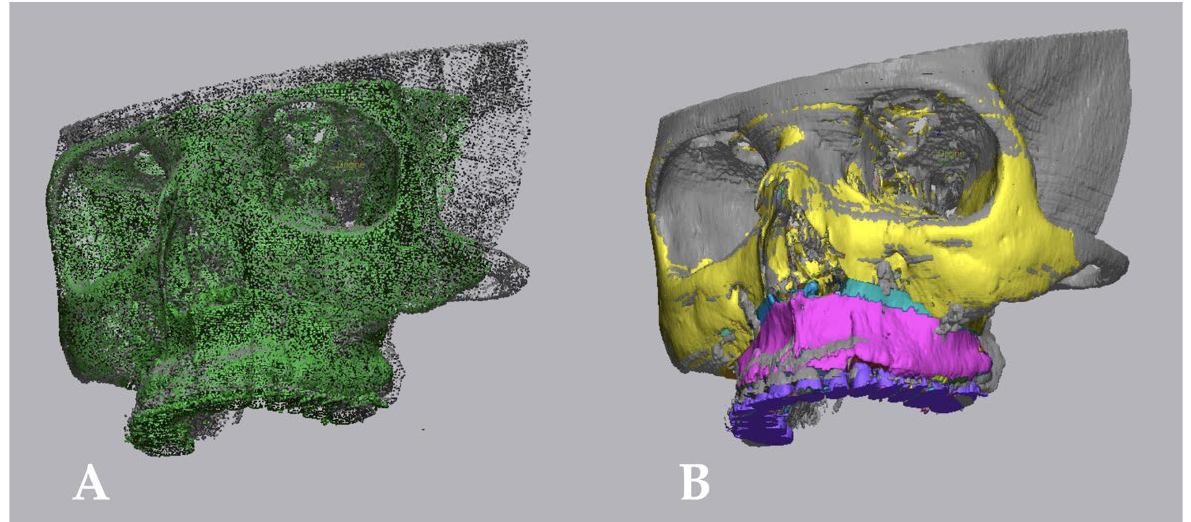
Figure 4. ( A ): Initial alignment of the meshes in ROI1. ( B ): Optimized alignment of the meshes in ROI1.